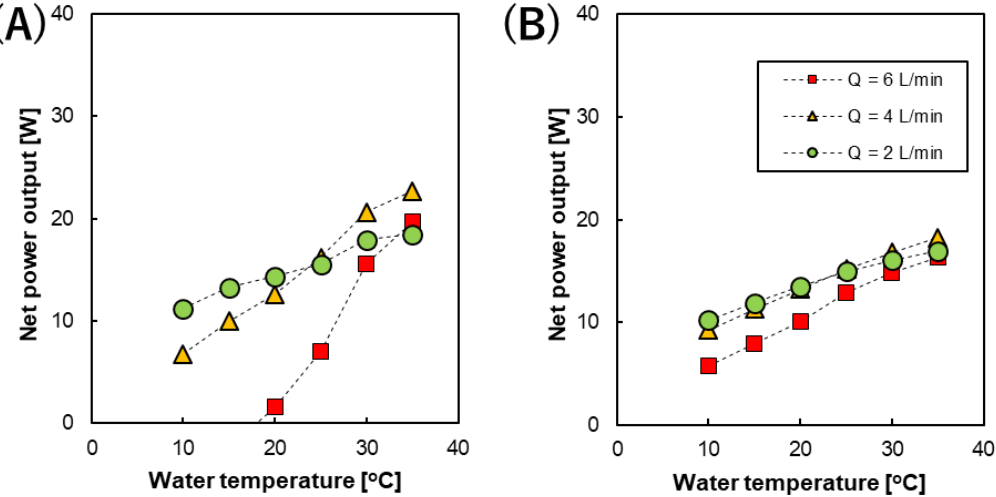
Figure 6 . The temperature dependence of the pumping energy calculated from the pressure drop of the stack with an intermediate distance of ( A ) 200 and ( B ) 600 µm at different feed solution flow rates.